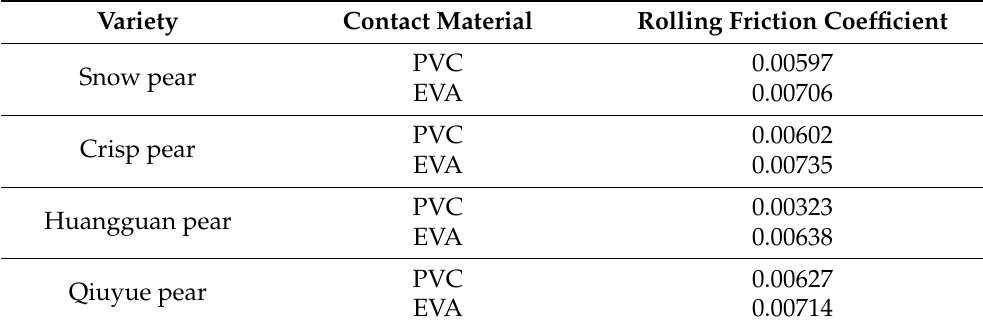
Table 9. Simulated values of static friction coefficient between other pear varieties and contact materials.